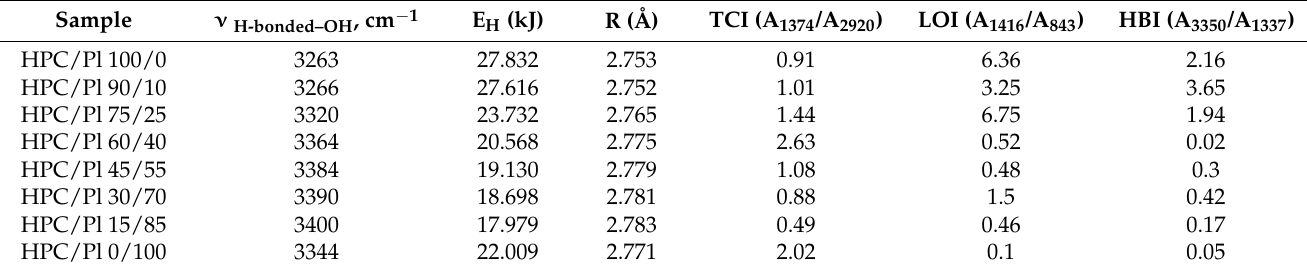
Figure 1. FT-IR spectra of the studied blends: ( a ) 3750–3050 cm − 1 ; ( b ) 3050–2700 cm − 1 ; ( c ) 1500–1200 cm − 1 ; ( d ) 1200–780 cm − 1 . Table 1. Curve-fitting results for the -O-H spectral region, energy and distances of the hydrogen bonds in the studied